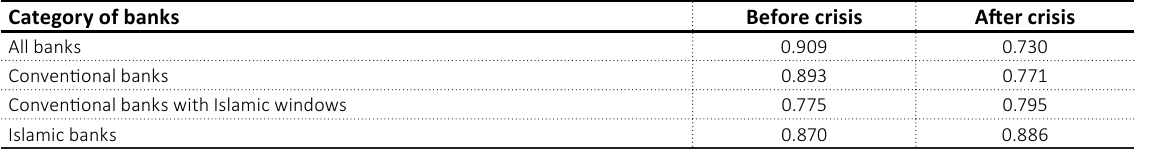
Table 12. Summary of conclusions Category of